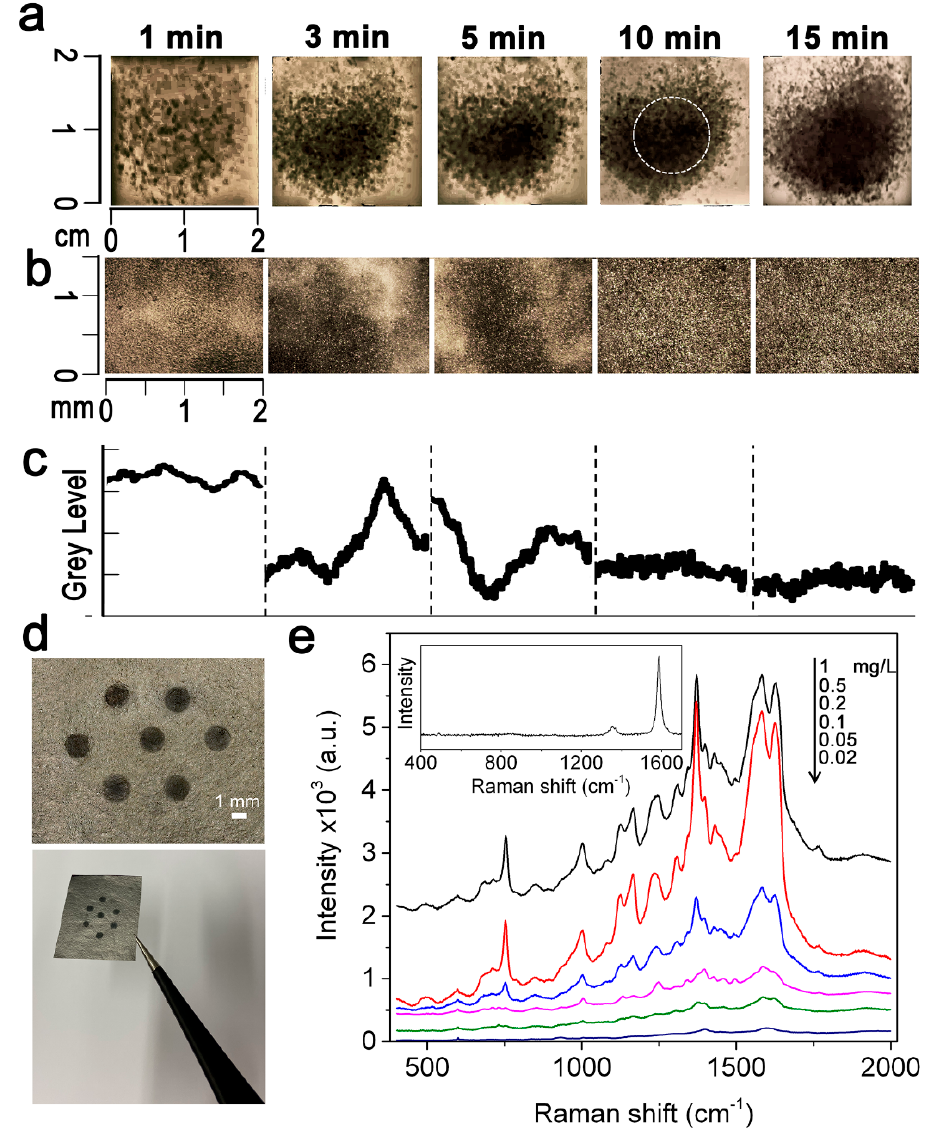
Figure 2. Fabrication of AgNWs@G-paper substrates. ( a ) Aerosol deposition of a 1 mg/L AgNW solution at different deposition times (varied from 1 min to 15 min) on a 2 × 2 cm 2 piece of G-paper. The central 1 × 1 cm 2 area of a AgNWs deposition showing a homogeneous density of deposited AgNWs (as highlighted by a dashed circle superposed on the sample at 10 min deposition) was considered for the following fabrication of patterned substrates (as in ( d )); ( b ) Optical micrographs showing a 2 × 2 mm 2 magnification of the central part of the substrates prepared in ( a ); ( c ) Grey level profiles showing the distribution of AgNWs within the areas considered in ( b ). A flat profile (as obtained after 10 min of AgNWs deposition) corresponds to a homogeneous AgNWs coating of G- paper; ( d ) Appearance of a AgNWs@G-paper substrate and a magnification of the AgNWs spot array as obtained by interposing a PET patterned mask between the nebulizing jet and the G-paper; ( e ) SERS spectra of Hb (1 × 10 − 6 M) on different AgNWs@G-paper substrates obtained by decreasing the density of nebulized AgNWs within the 1 ÷ 0.02 mg/L range once set the deposition time to 10 min (black, 1 mg/L; red, 0.5 mg/L; blue, 0.2 mg/L; purple, 0.1 mg/L; green, 0.05 mg/L; blue 0.02 mg/L). The 0.5 mg/L density provides the most intense Hb signals and was thus selected for further production of AgNWs@G-paper substrates. Spectra represent the average of over 20 acquisitions. Inset: Raman spectrum of G-paper.